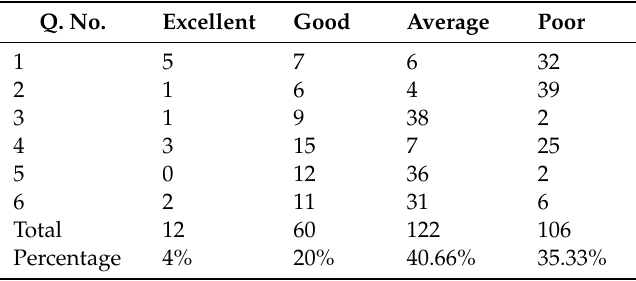
Table 5. Group I based on Questions